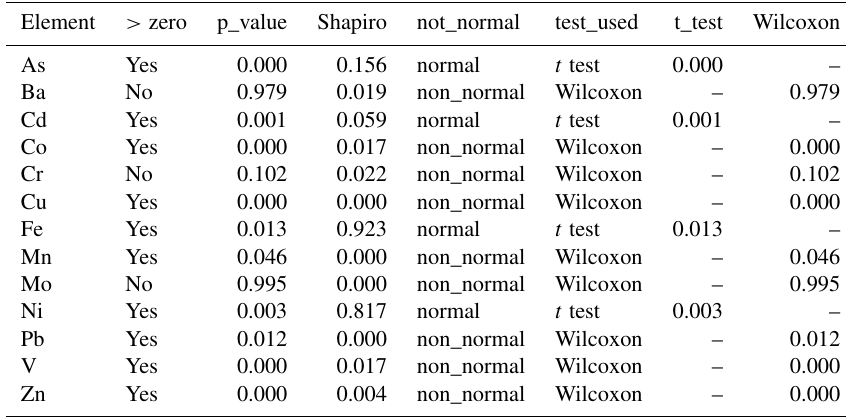
Table 5. Are dust-corrected plankton concentrations statistically different from zero for 2014